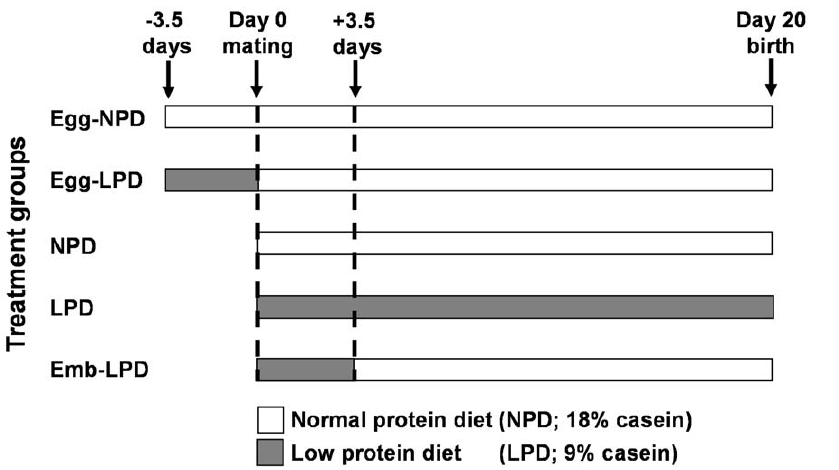
Figure 1. Diagram depicting the 5 dietary regimes used in this study. Females were fed either normal protein diet (NPD) throughout oocyte maturation (3.5 days prior to mating; Egg-NPD), low protein diet (LPD) exclusively during oocyte maturation (Egg-LPD), NPD though out gestation, LPD throughout gestation (LPD) or LPD exclusively during preimplantation development (3.5 days following mating; Emb-LPD).